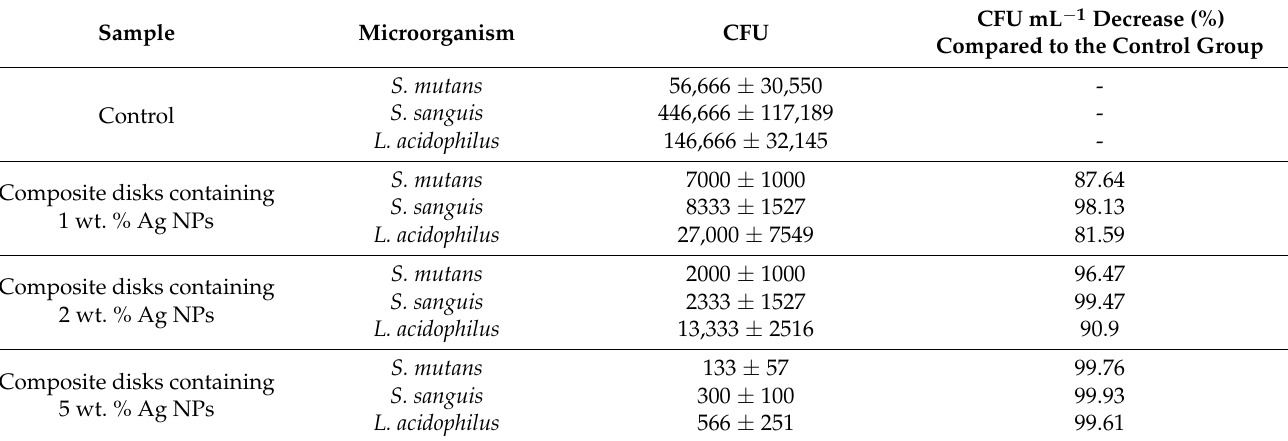
Table 6. Results of biofilm inhibition tests for S. mutans , S. sanguis , and L. acidophilus for composite disks containing Ag NPs and control